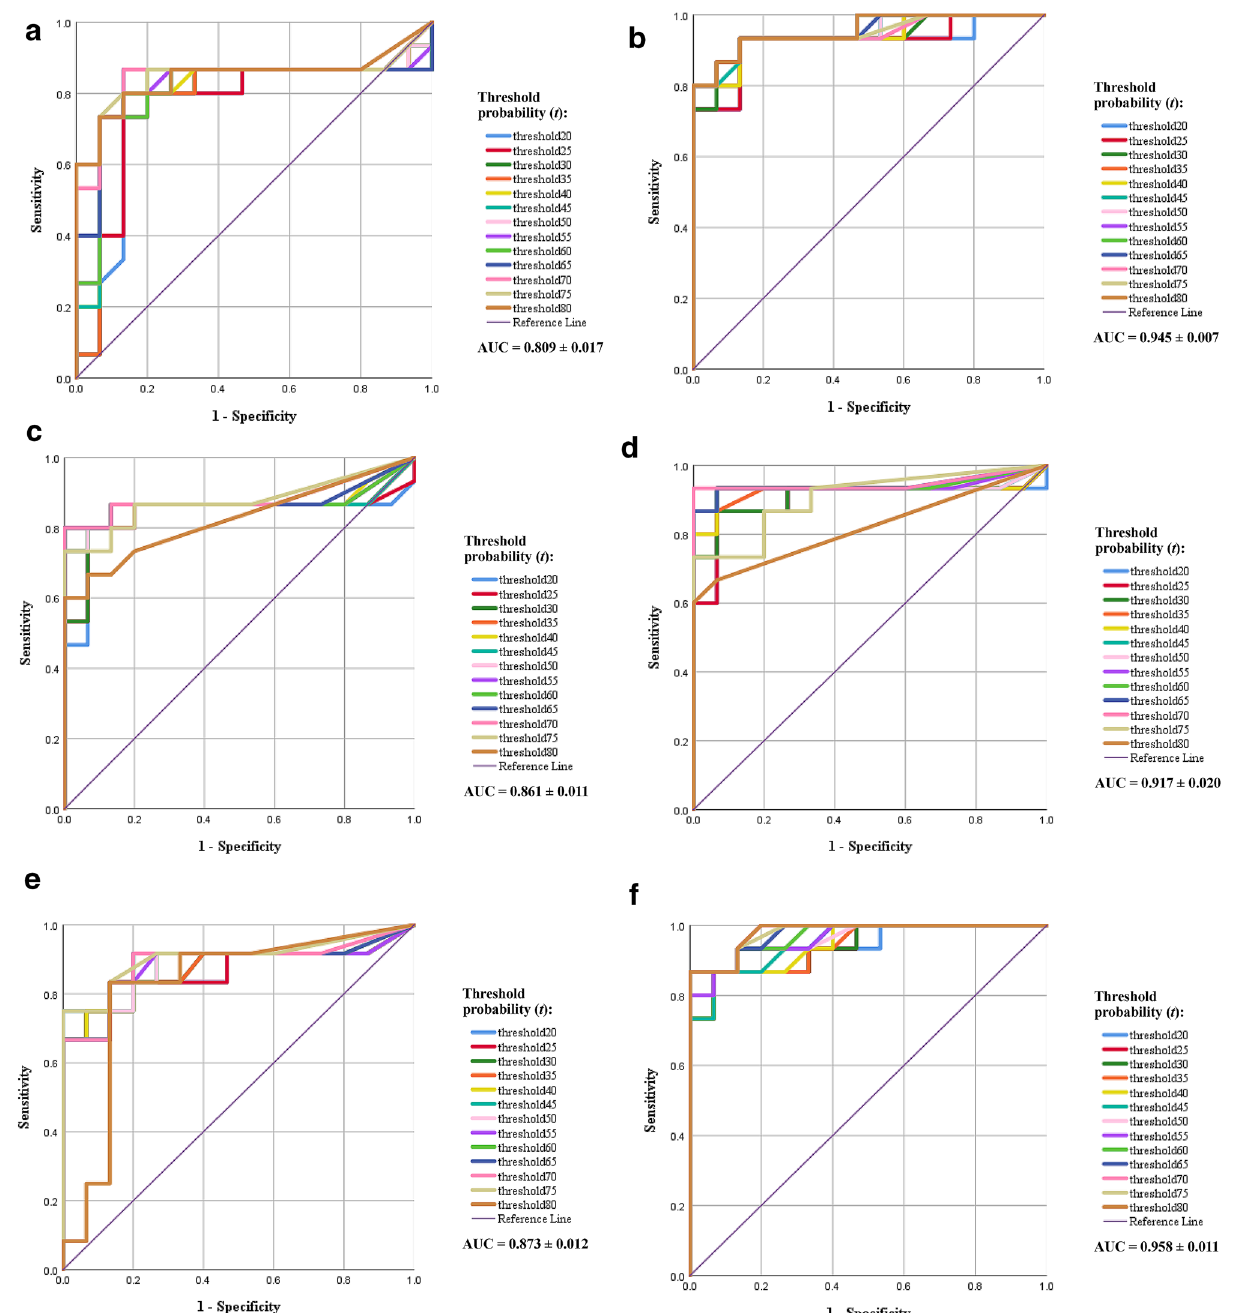
Figure 4. ROC curve and average AUC for each model and the threshold probability of the learning method with the YOLO network models. ( a , b ) Correspond to the one-stage and two-stage methods of tiny YOLO v2, respectively. ( c , d ) Correspond to the one-stage and two-stage methods of YOLO v2, respectively. ( e , f ) correspond to the one-stage and two-stage methods of YOLO v3,